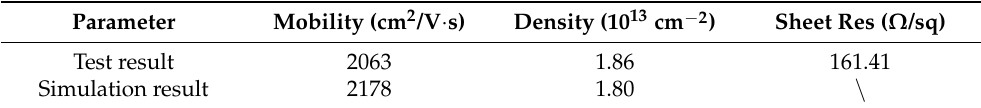
Table 1. HALL test results of the designed epitaxy.